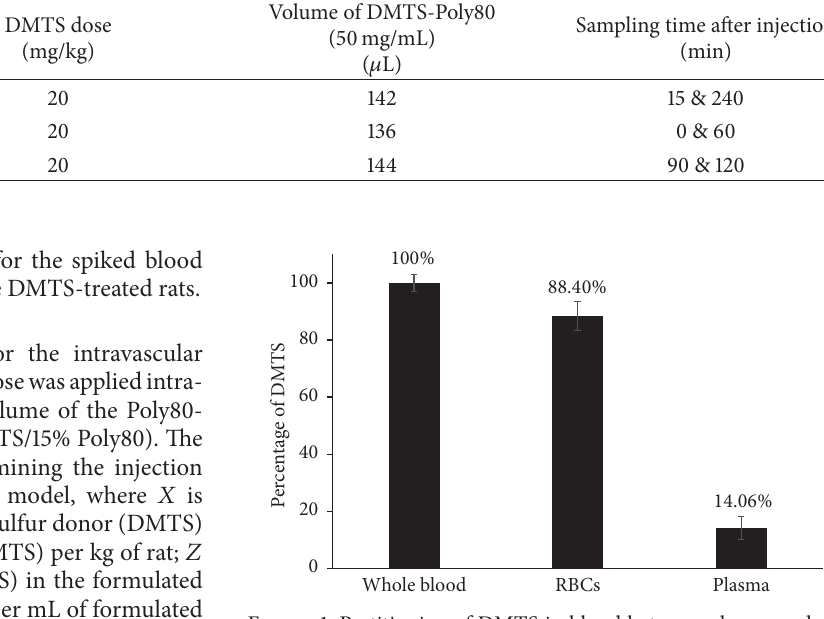
Figure 1: Partitioning of DMTS in blood between plasma and red blood cells (RBCs). Results represent the mean ± SD; 𝑛 = 3